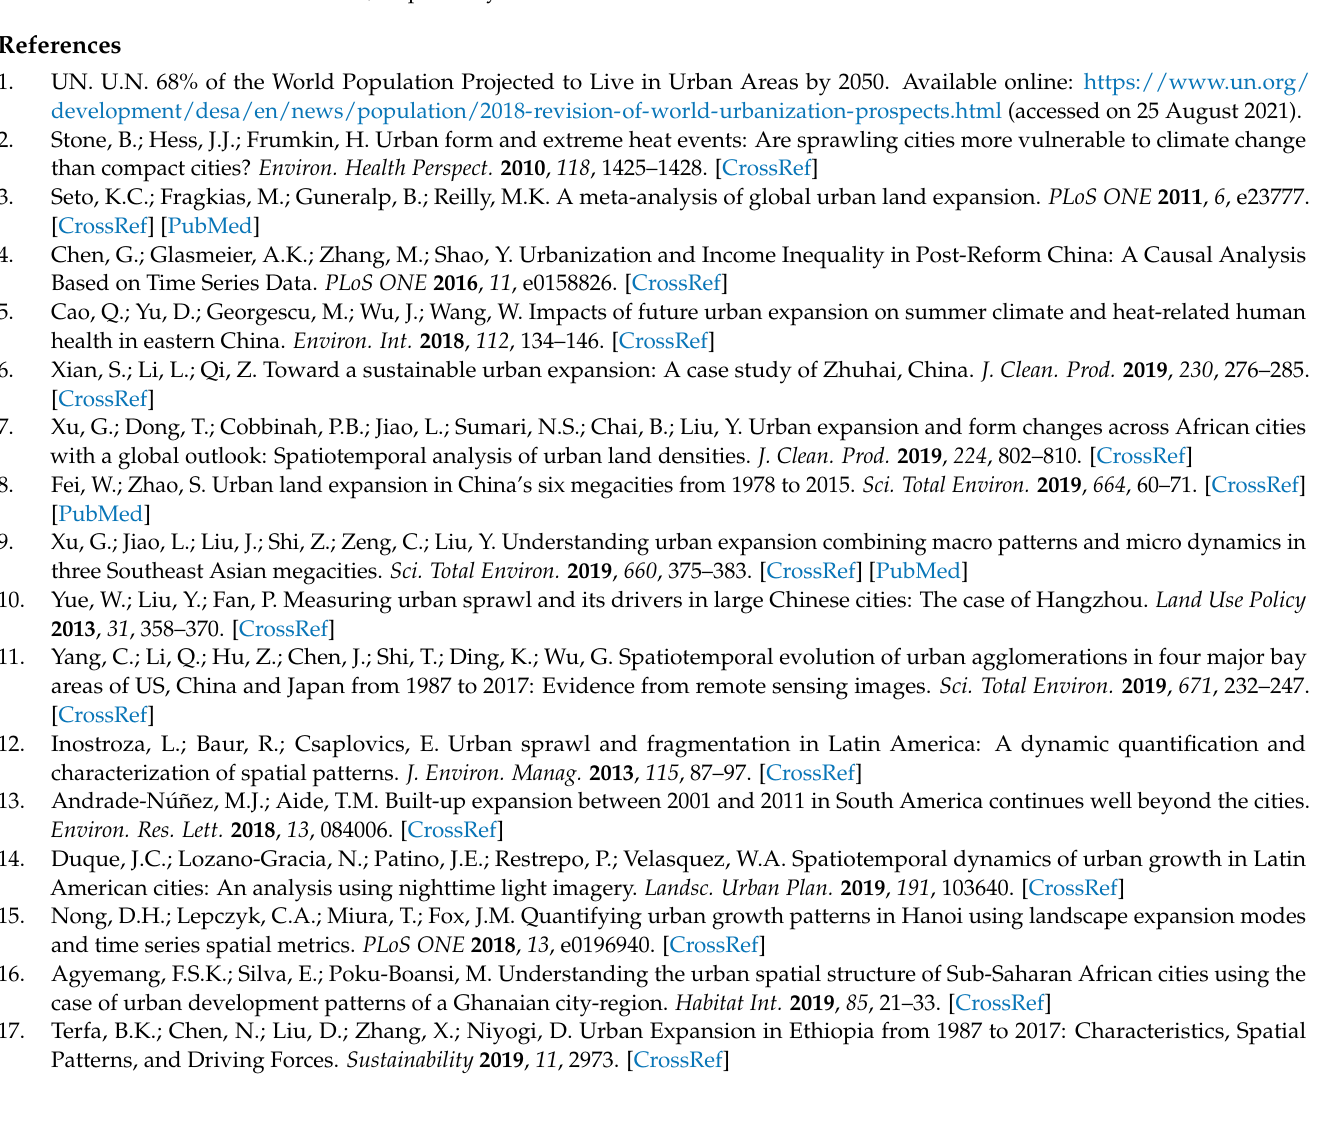
Figure A1. Landscape metrics computed based on the sectors of the concentric buffers–geographic directions system. ( a ) Mean β -score and ( b ) Mean γ -score reflect the capability of the landscape metrics to recognize the urban expansion patterns in the Federal District of Brazil over space and time, respectively.